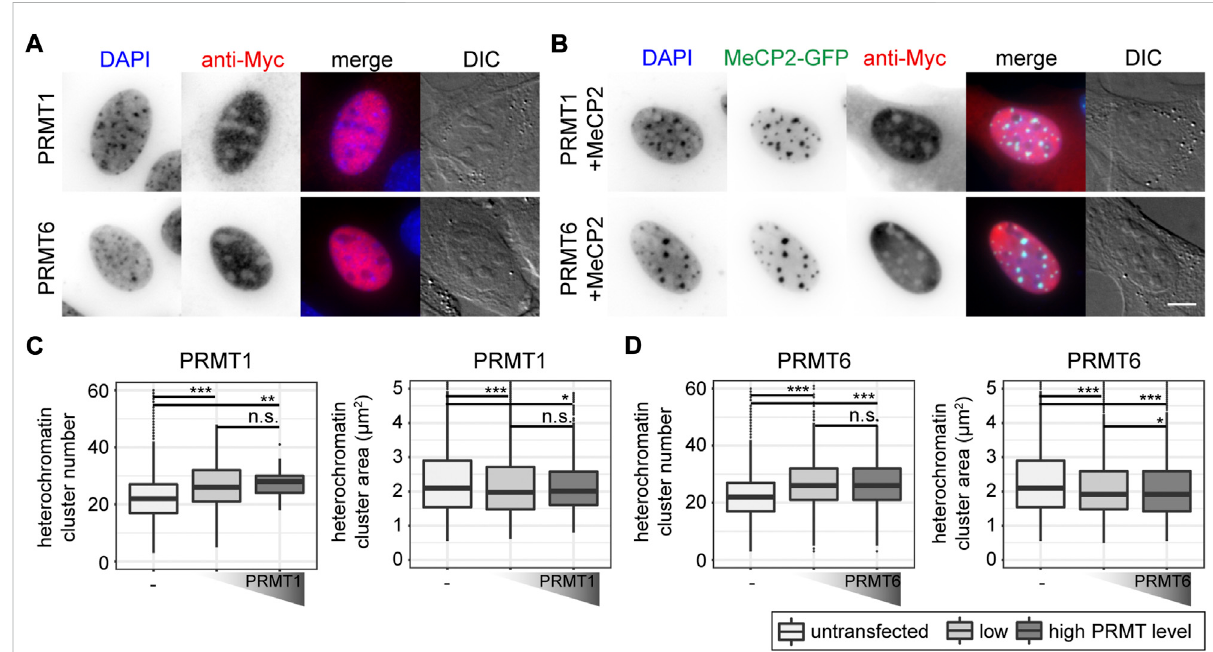
FIGURE 6 Subcellular localization of PRMT1 and PRMT6 constructs transfected in C2C12 mouse myoblast cells in the absence (A) and presence (B) of MeCP2.Scalebar5 µm.BoxplotsdepicttheheterochromatinclusteringinC2C12cellswithoutandwithlowandhighlevelsofnuclearPRMT1 (C) and 6 (D) represented by the number and size of the heterochromatin clusters obtained from high-content screening microscopy. Two biological replicates, statistical signi fi cance calculated using Wilcoxon-Rank test. * p < 0.05, ** p < 0.005, *** p < 0.001, n. s Not signi fi cant. p -values and n-values are summarized in Supplementary Table